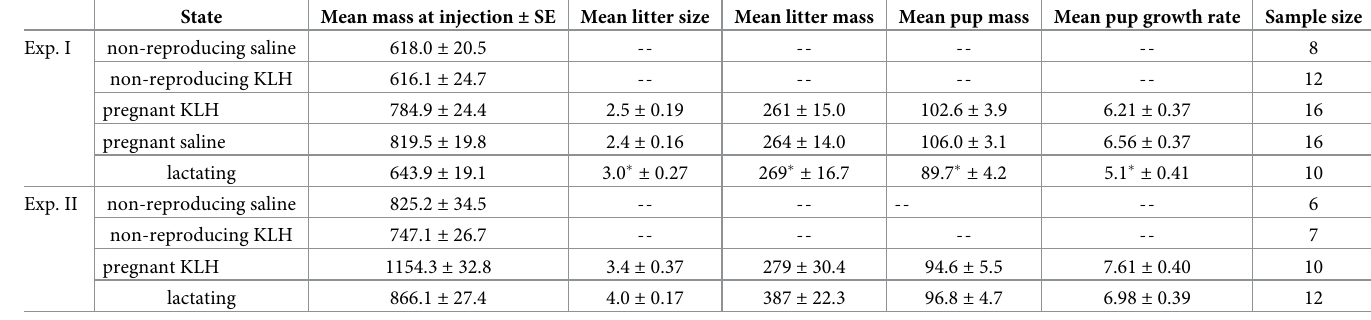
Table 2. Body mass at first injection of females and data on reproductive output in Experiment I and II. See text for statistics. KLH: Injected twice at one week interval with an isotonic solution of KLH. Saline: Injected twice at one week interval with an isotonic saline